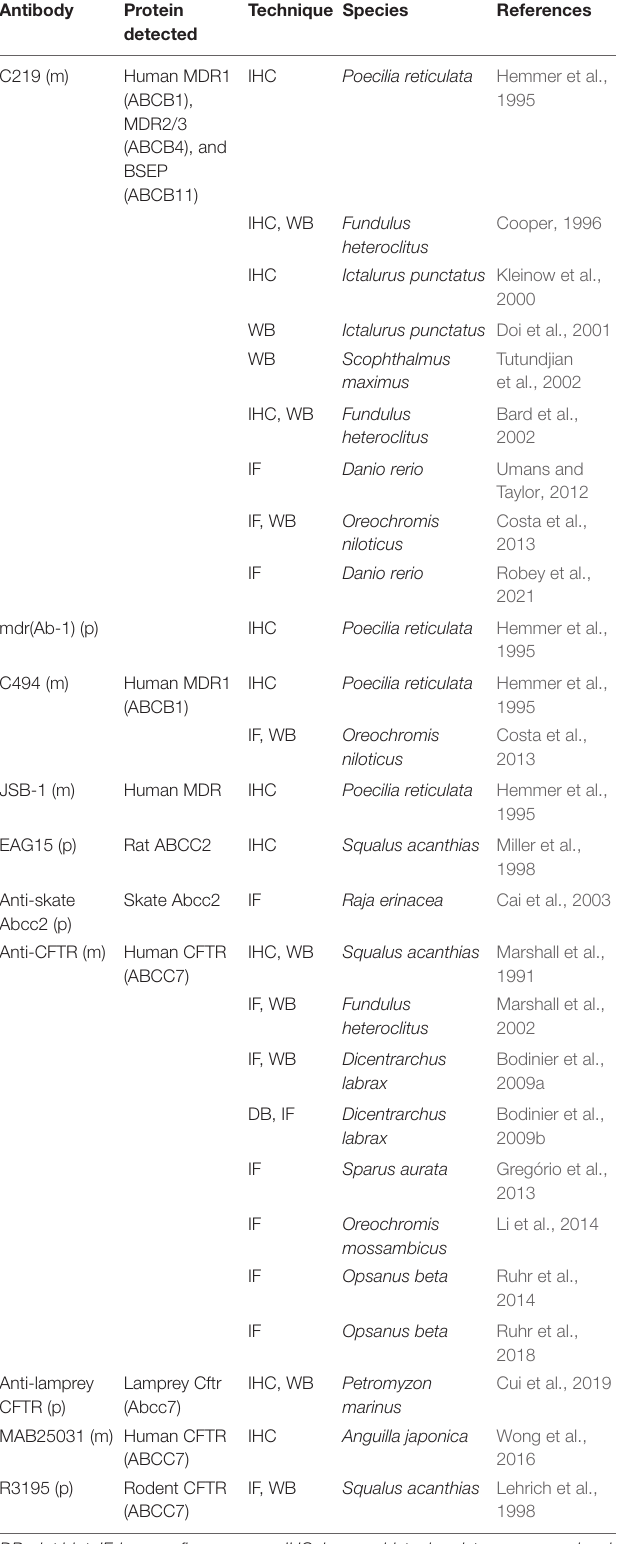
TABLE 2 | Antibodies utilized to detect fish intestine ABC